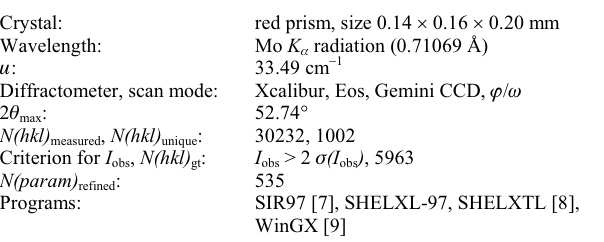
Table 1. Data collection and